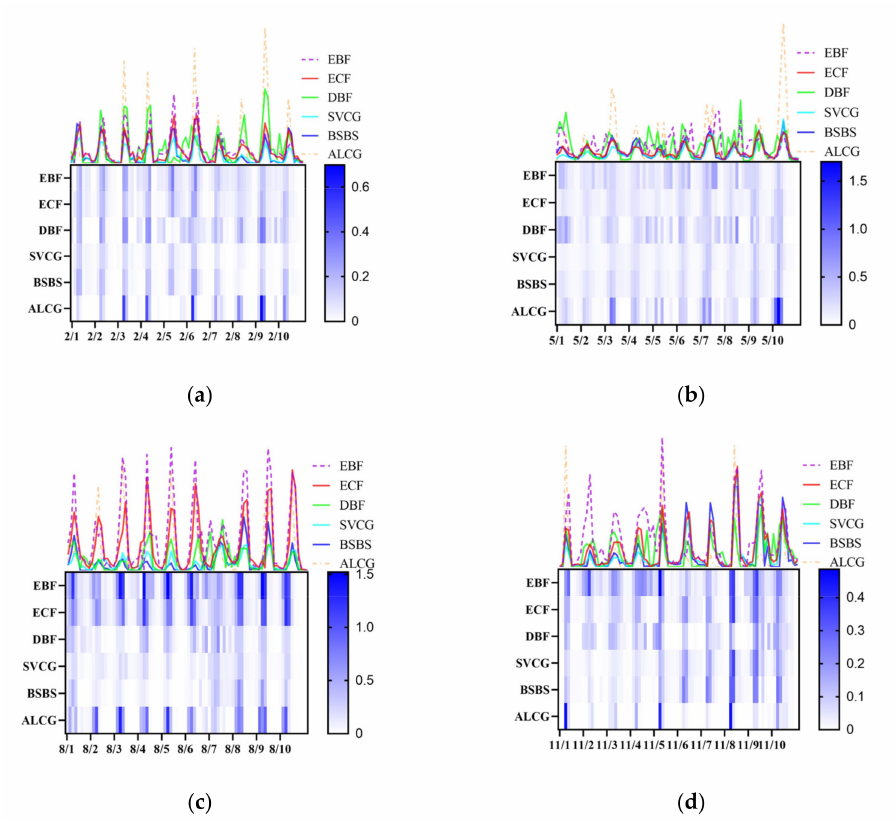
Figure 6. Daily ET for six type of vegetation. ( a – d ) are the daily ET of the EBF, ECF, DBF, SVCG, BSBS, ALCG in February, May, August and November,